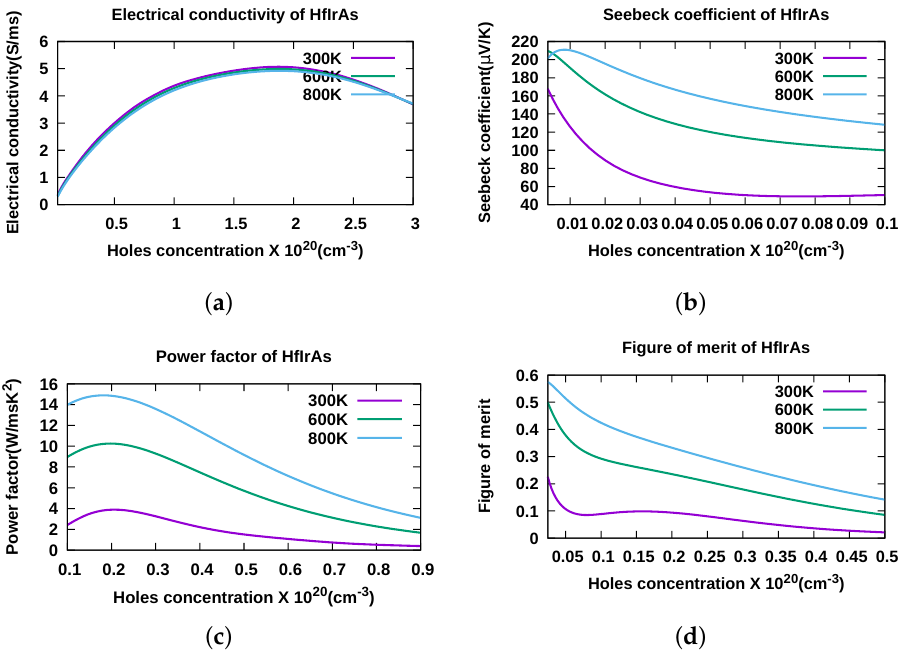
Figure 4. Transport coefficients of HfIrAs